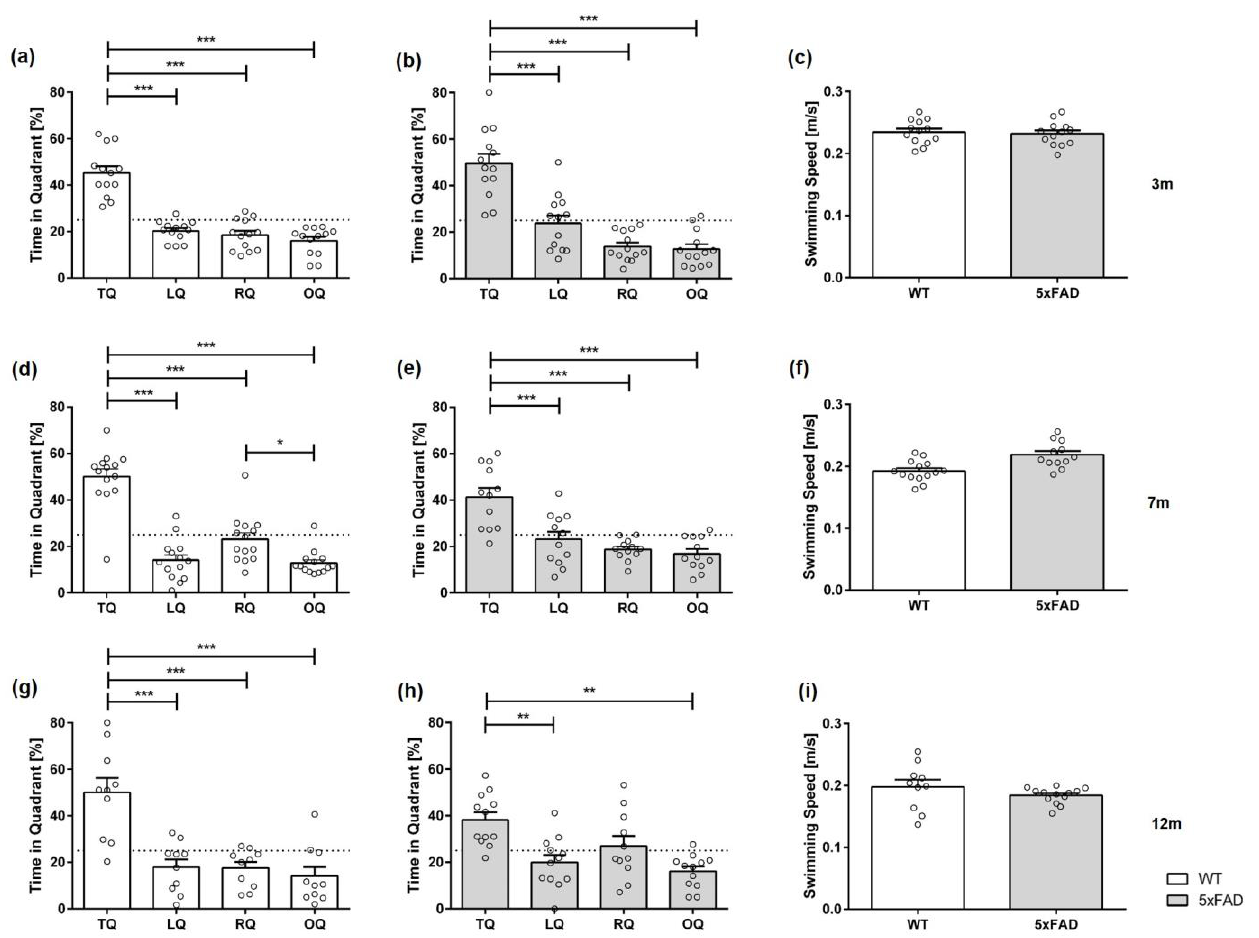
Figure 5. Aged male 5xFAD mice show mild spatial reference memory deficits in the probe trial. 3- and 7-month-old 5xFAD ( b , e ) mice and WT animals ( a , d , g ) showed a clear preference for the target quadrant. In contrast, 12-month-old 5xFAD mice demonstrated no clear preference for the target quadrant ( h ). No difference in swimming speed between 5xFAD and WT mice ( c , f , i ). TQ = target quadrant, LQ = left quadrant, RQ = right quadrant, OQ = opposite quadrant. Data presented as mean ± S.E.M., n = 10 – 13. Quadrant preference: one-way repeated measures ANOVA followed by Bonferroni correction for multiple comparisons: * p < 0.05, ** p < 0.01, *** p < 0.001. Swimming speed: unpaired t -test.